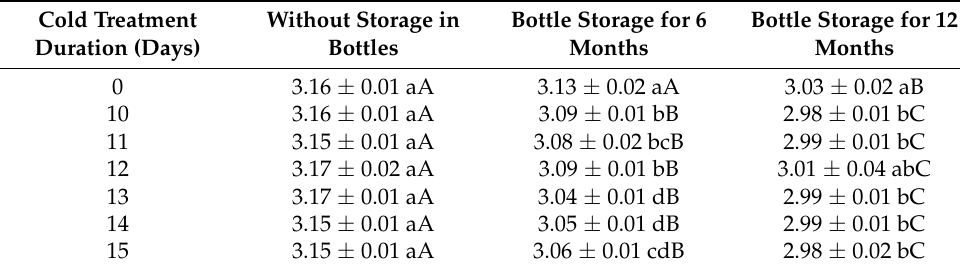
Table 1. Effects of cold treatment duration and bottle storage duration on wine pH